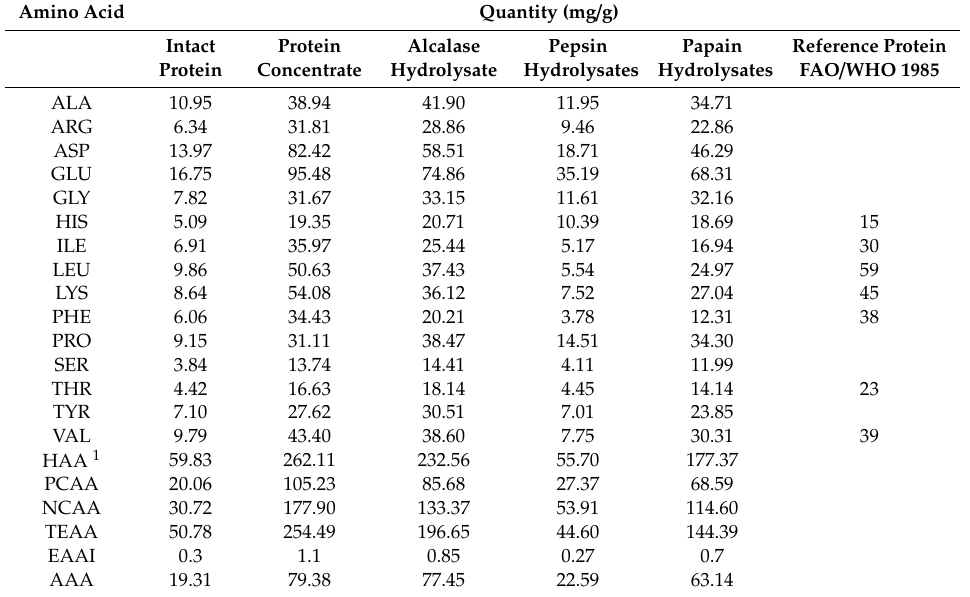
Table 2. Amino acid composition of BSF intact protein, protein isolate and hydrolysates 1 . Amino Acid Quantity (mg / g) Intact Protein Alcalase Pepsin Papain Reference Protein Protein Concentrate Hydrolysate Hydrolysates Hydrolysates FAO / WHO